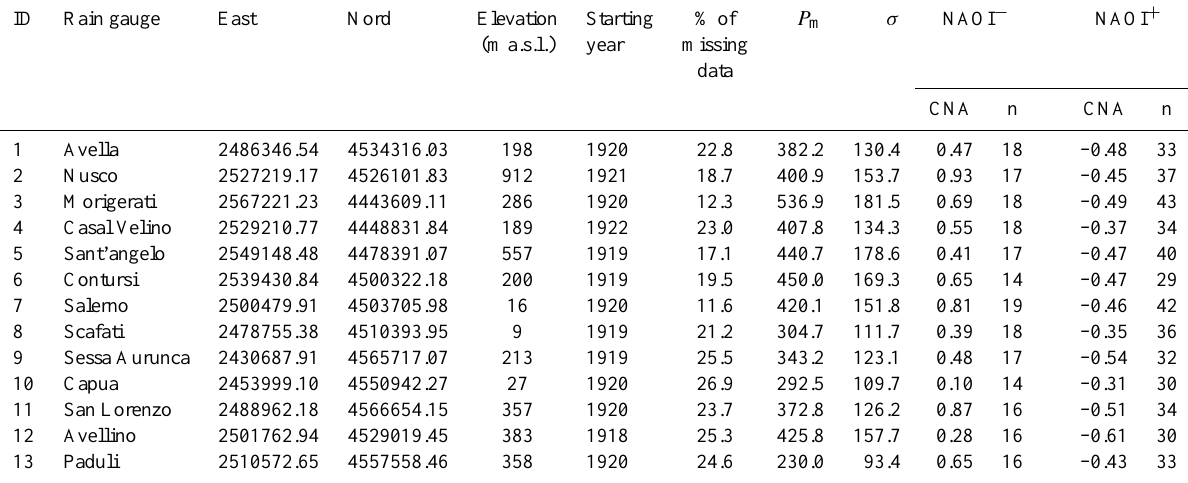
Table 1. Results of the composite analysis between the winter precipitation series and the NAOI. For each rain gauge, characterized by the long-term precipitation average P m and the standard deviation σ of the whole series, the CNA and the length of the subseries (n) were reported with reference both to the negative (NAOI) and the positive (NAOI + ) extreme phases of the index. (Geographic Coordinate System: Monte